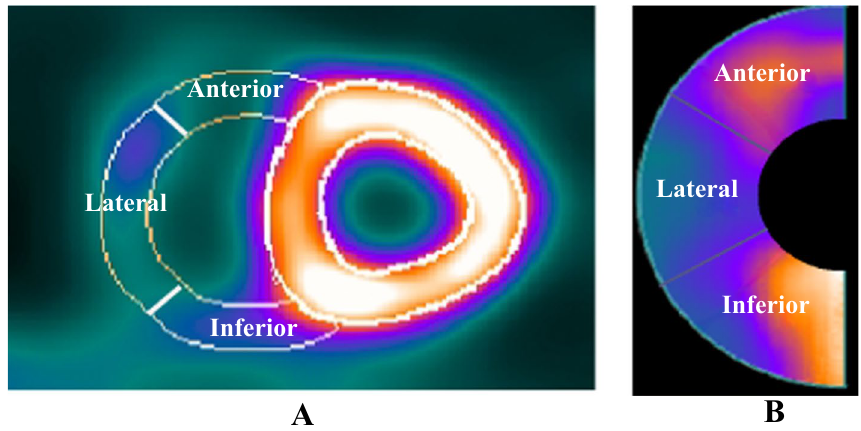
Fig. 4 Representation of three subsegments of the RV wall in the A short-axis view and B the polar map; The RV wall is segmented into three subsegments: anterior, lateral, and inferior